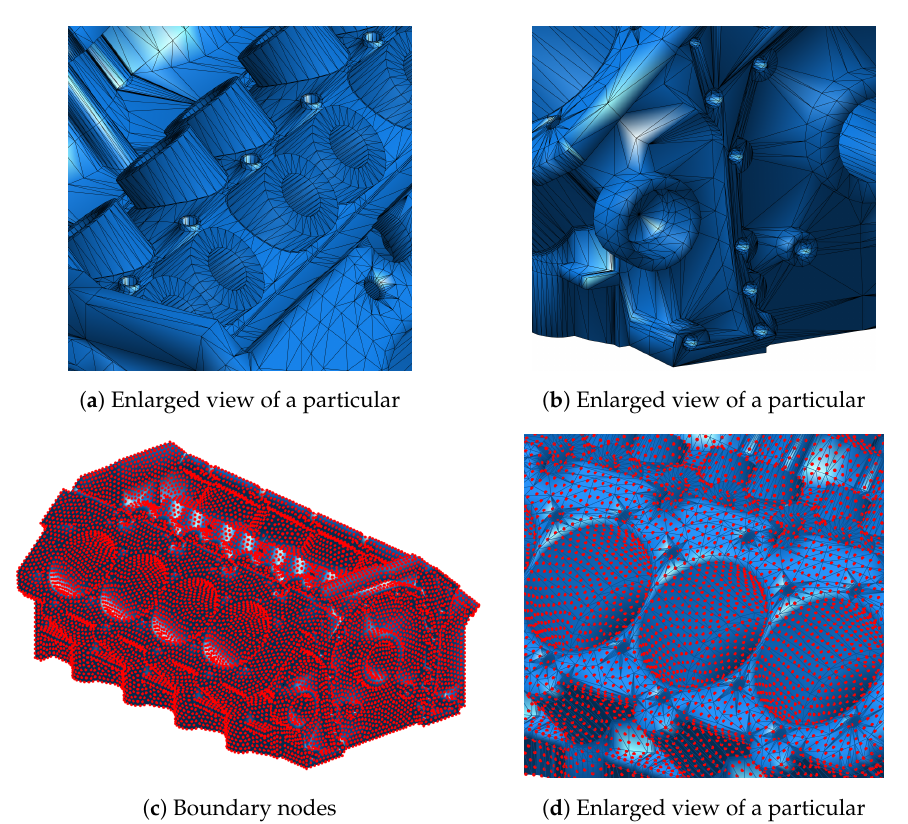
Figure 3. Enlarged views of some details of the .stl crankcase model and an example of node distribution with N ≈ 75k